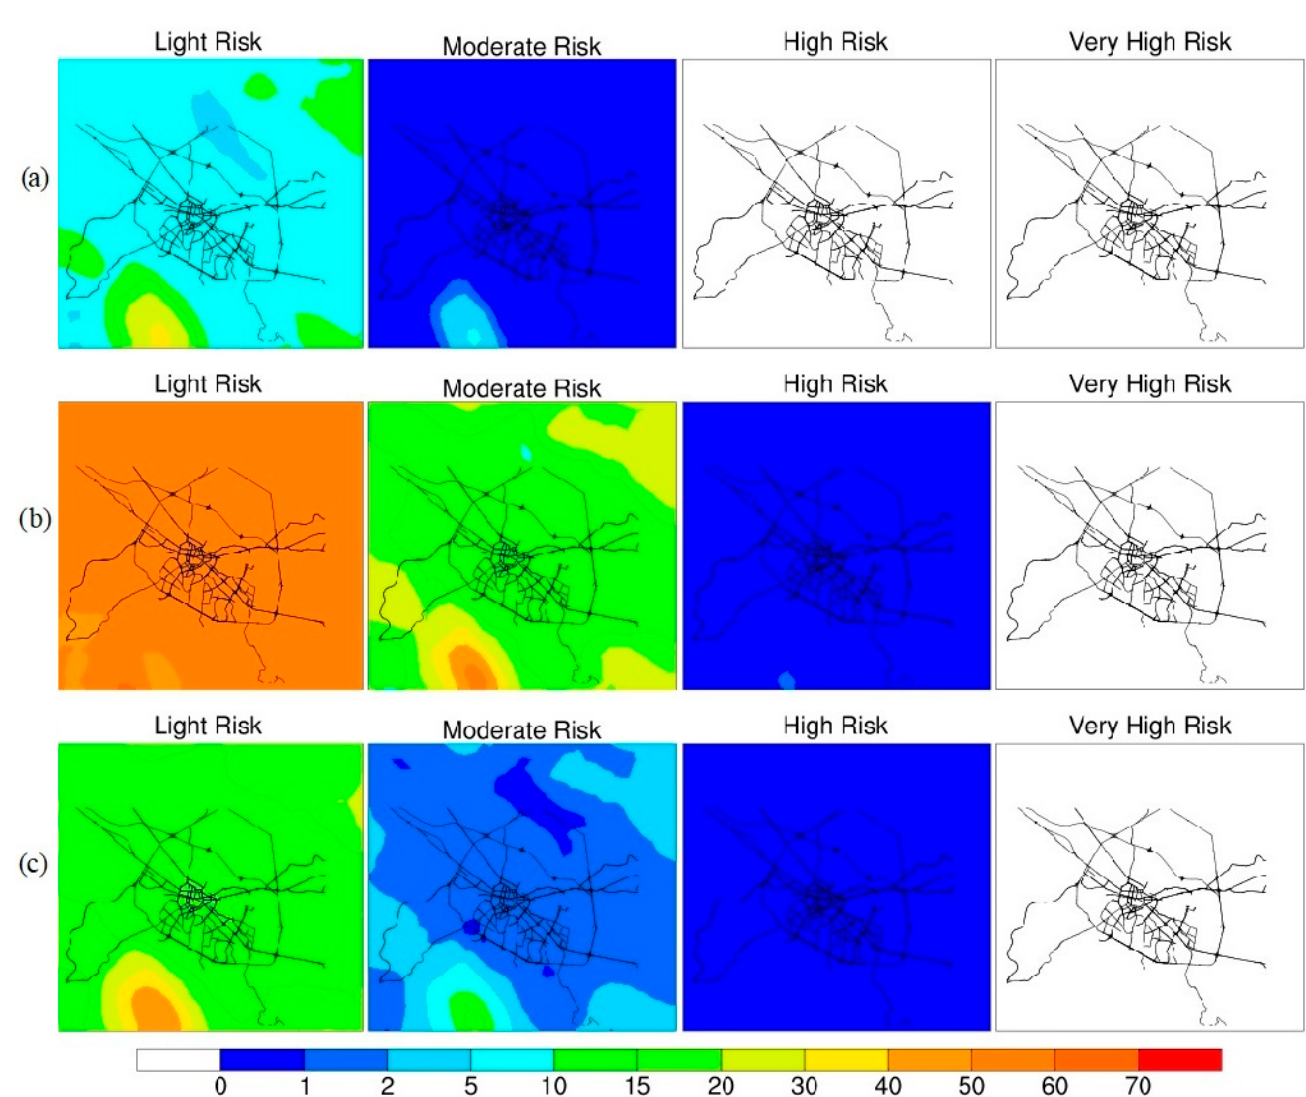
Figure 7. Frequency (in %) for ( a ) autumn, ( b ) winter, and ( c ) spring of the Wind chill categories in the Sofia region during the spring (first row), summer (second row), and autumn (third row).